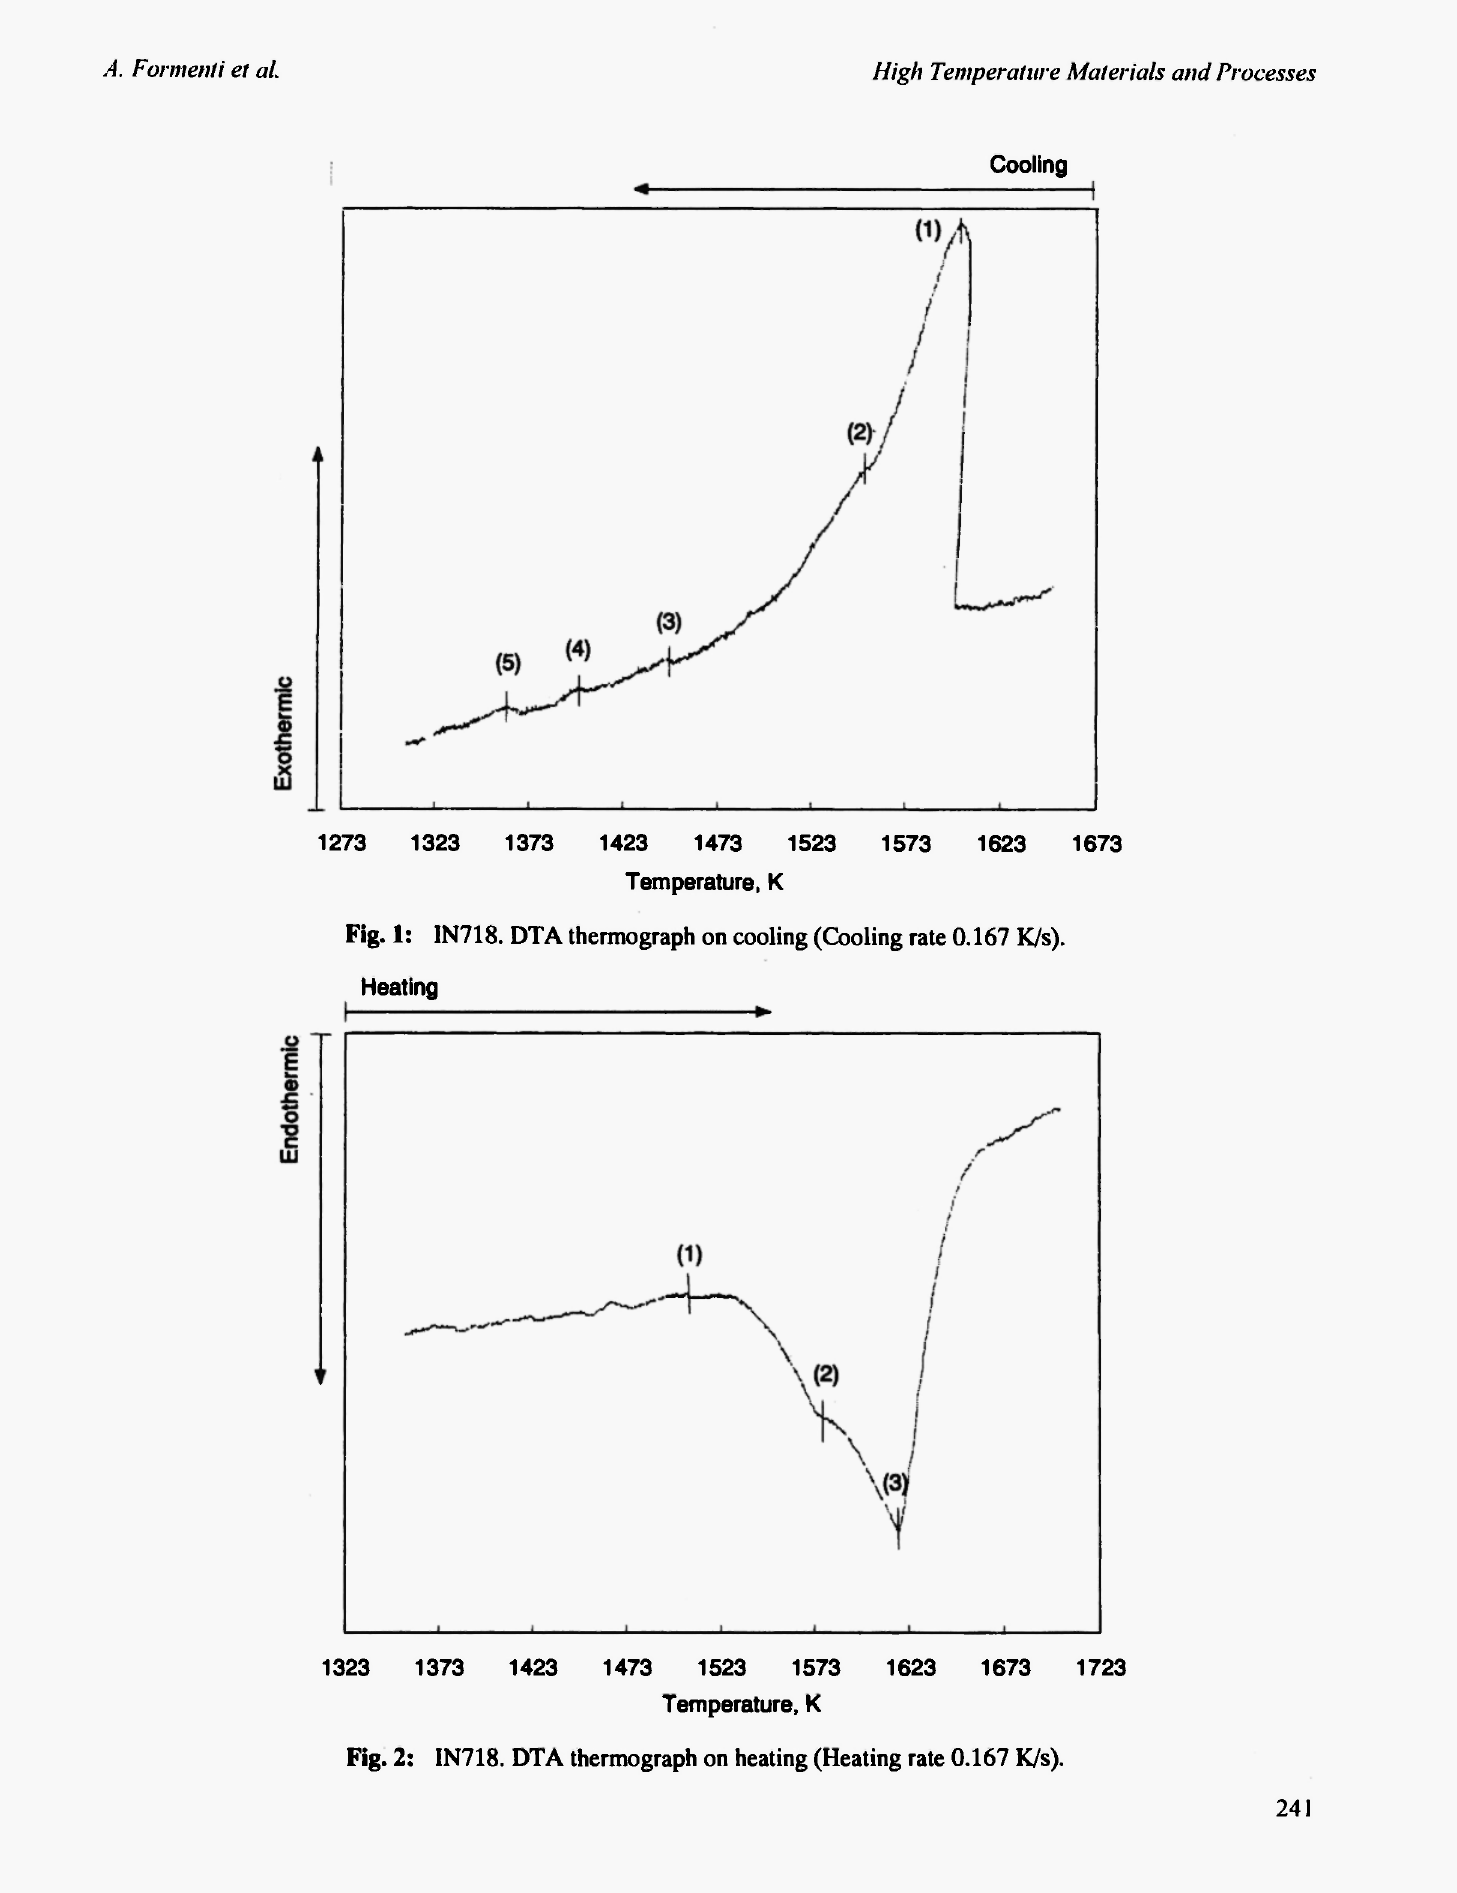
Fig. 2: IN718. DTA thermograph on heating (Heating rate 0.167